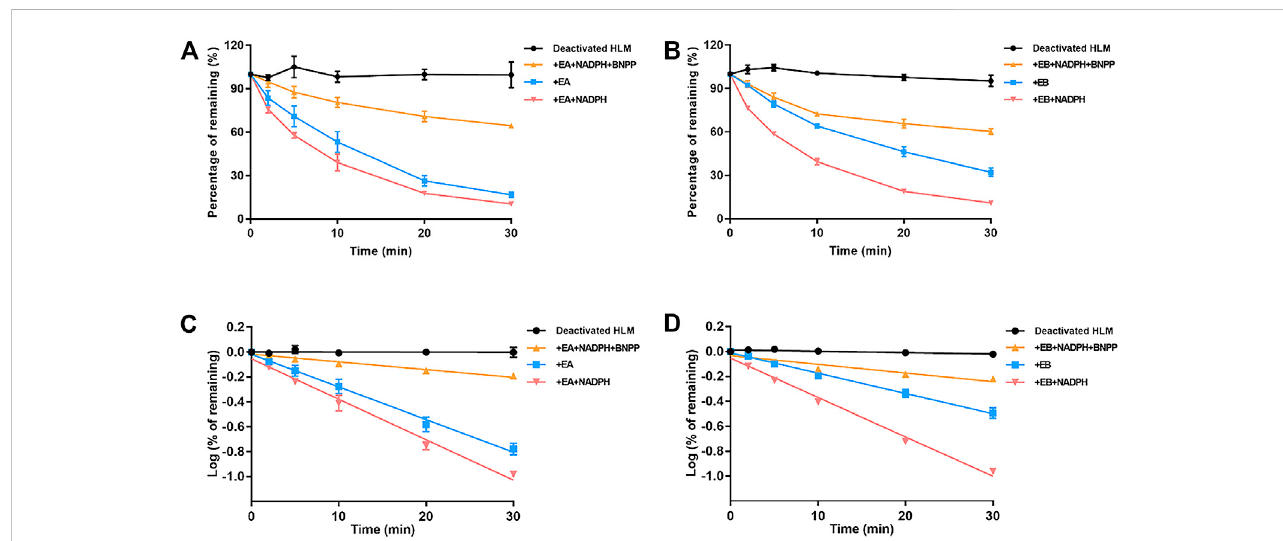
FIGURE 5 Contributions of carboxylesterase and CYP to EA (A,C) and EB (B,D) metabolism in HLMs. Deactivated HLMs were used as negative control (mean ± SD; n =